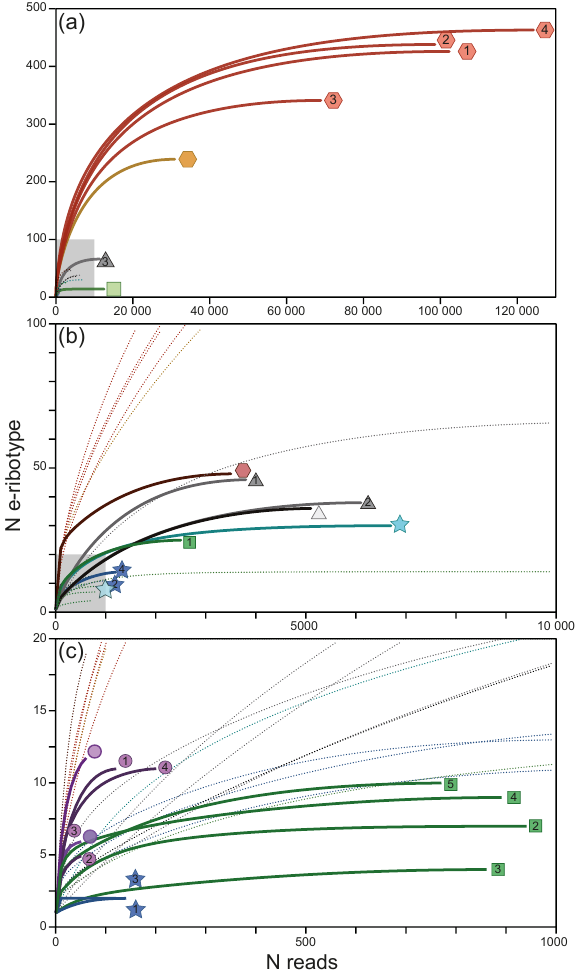
Figure 2. Rarefaction curves. E -ribotype rarefaction curves of each of the 28 samples containing planktonic foraminifera sequences. The three boxes show the same rarefaction curves at three differ- ent scales highlighted by grey rectangles. For each magnification, the curves which are out of range are drawn in dashed lines to ease the reading of the